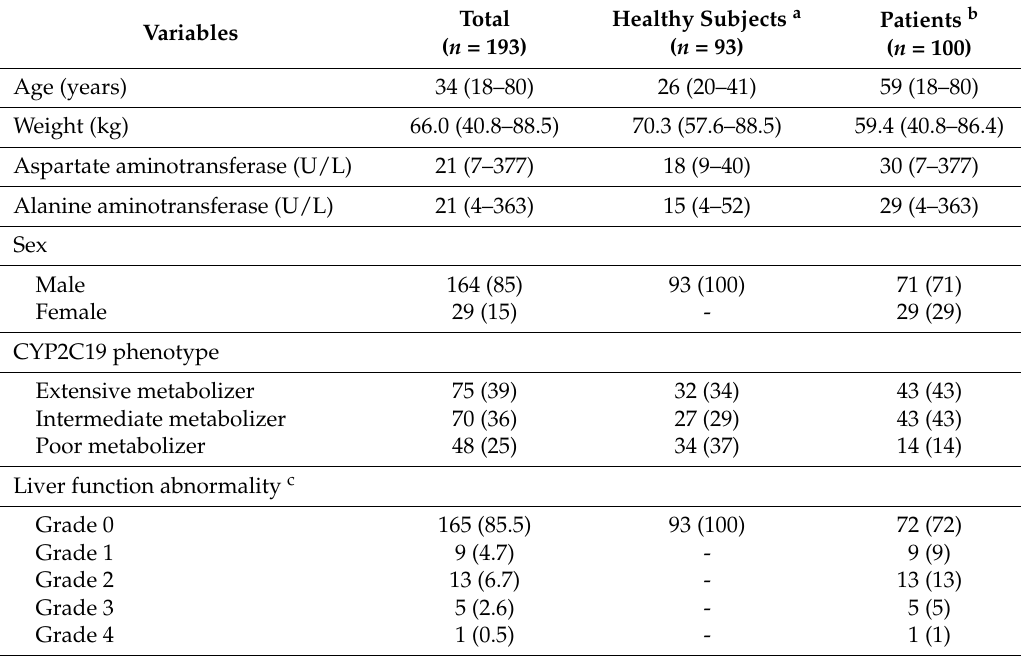
Table 1. Demographic and clinical characteristics of study